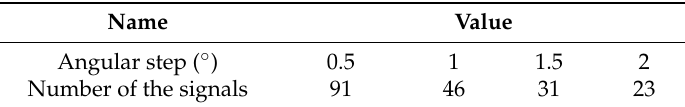
Table 2. The numbers of the receiving signals for different angular